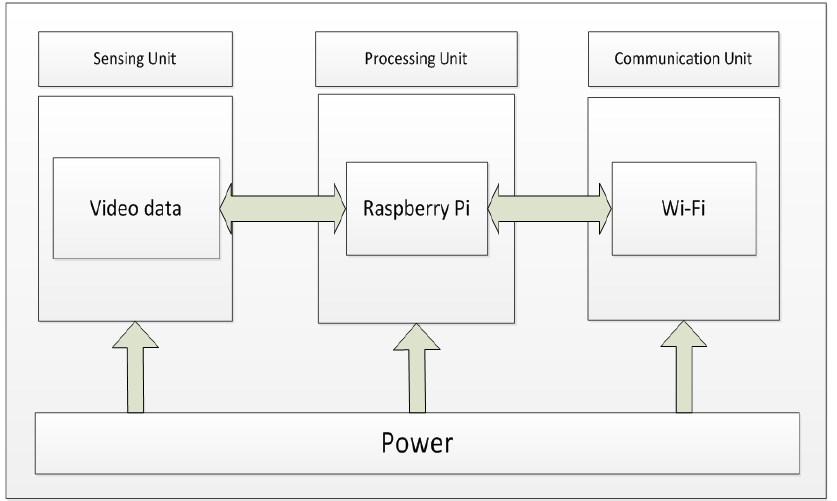
Figure 3. Sensor node architecture.